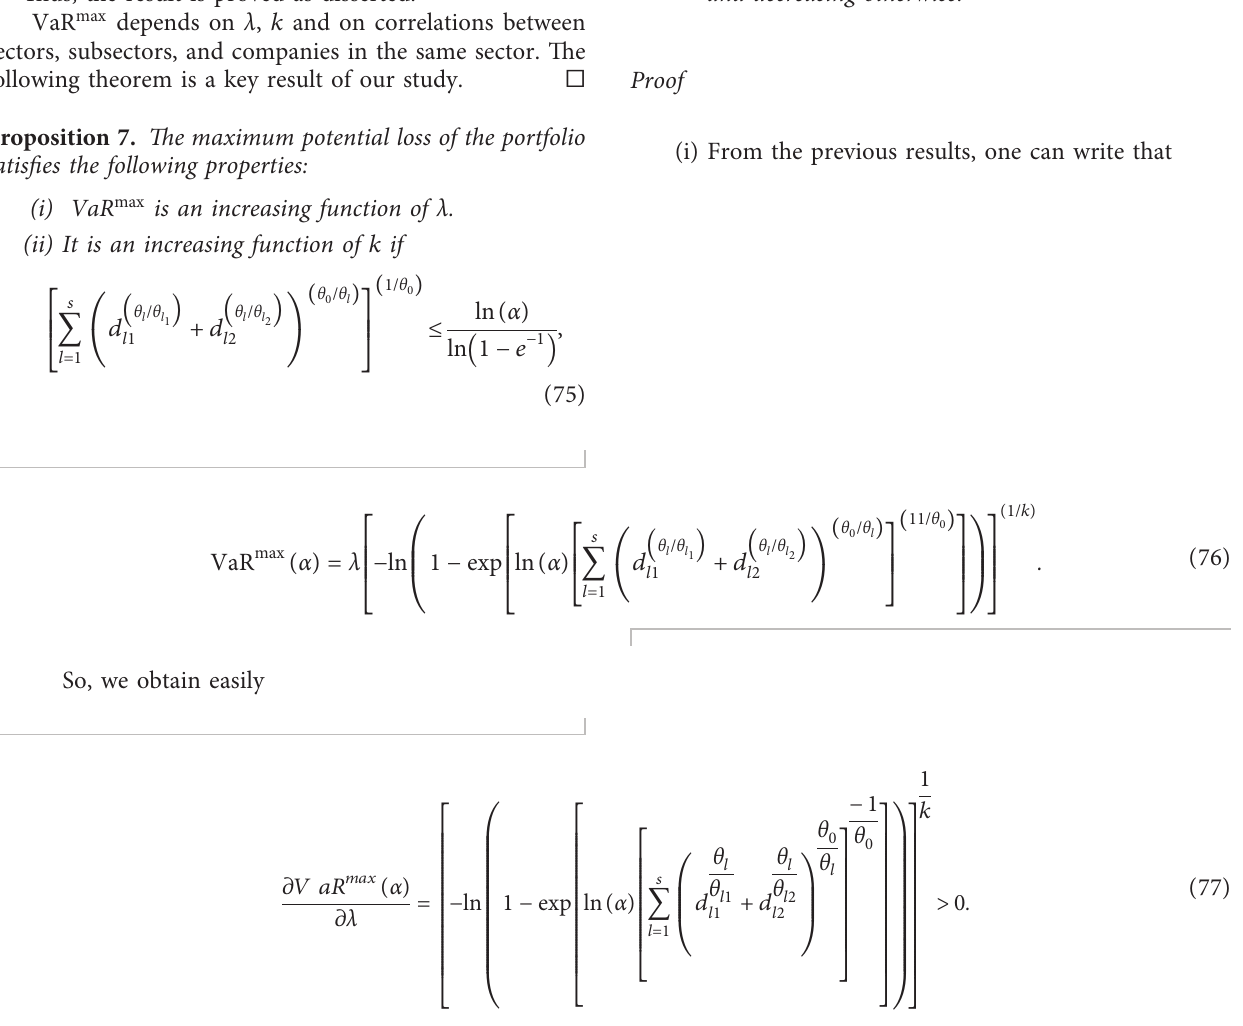
Figure 4: Maximum of the value at risk as a function of confidence level α for d � 9, θ � 8 , 5, θ � 9 , 5 for all l ∈ 1 , ... , s { } and i ∈ 1 , 2 { } in the portfolio made up of 3 θ 22 31 32